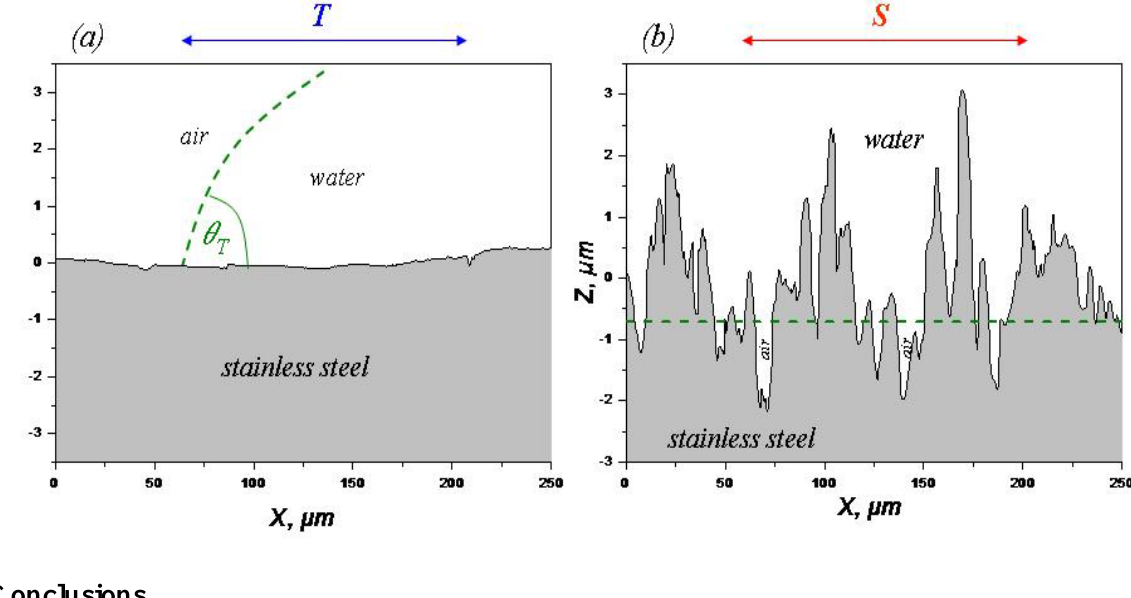
Figure 14. 2D-profiles and the calculated air interface height for Sample 5 using the topographical data. Complete wetting in the direction parallel to the grooves ( a ), and partial wetting ( b ) in the direction perpendicular to the grooves with a calculated solid fraction at h = − 0.708 µm (Table